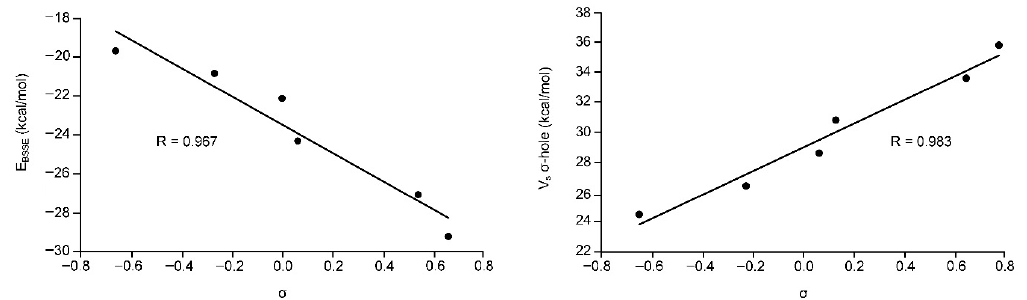
Figure 4. ( Left ) Hammett’s plot (E BSSE vs. σ ) of Complexes 7 to 12 . ( Right ) Regression plot of the MEP values at the σ -hole (V s σ -hole) versus the aromatic p -substituent constant ( σ ) for Complexes 7 to 12 .